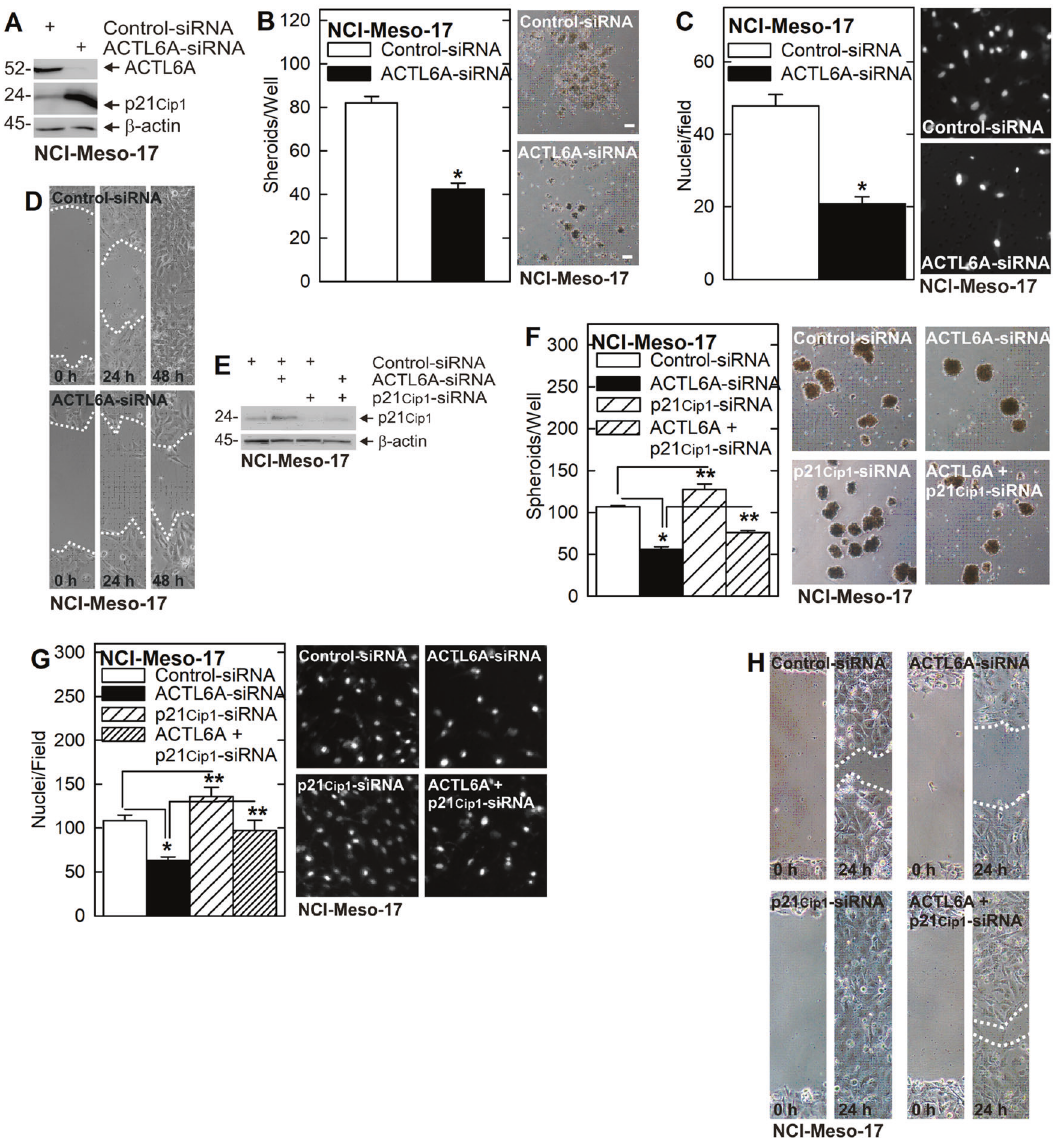
Fig. 3 ACTL6A maintains the NCI-Meso-17 cancer cell phenotype. A – D ACTL6A knockdown increases p21 Cip1 protein level and is associated with reduced spheroid formation, invasion, and migration. E – H ACTL6A knockdown increases p21 Cip1 levels and reduces spheroid formation, invasion, and migration and p21 Cip1 knockdown partially reverses the ACTL6A-knockdown dependent reduction in spheroid formation, invasion, and migration. These fi ndings suggest that ACTL6A suppresses p21 Cip1 to maintain the aggressive NCI-Meso-17 cell cancer phenotype. Single asterisks indicate a signi fi cant decrease ( n = 3, p ≤ 0.001) and double asterisks indicate a signi fi cant increase ( n = 3, p ≤